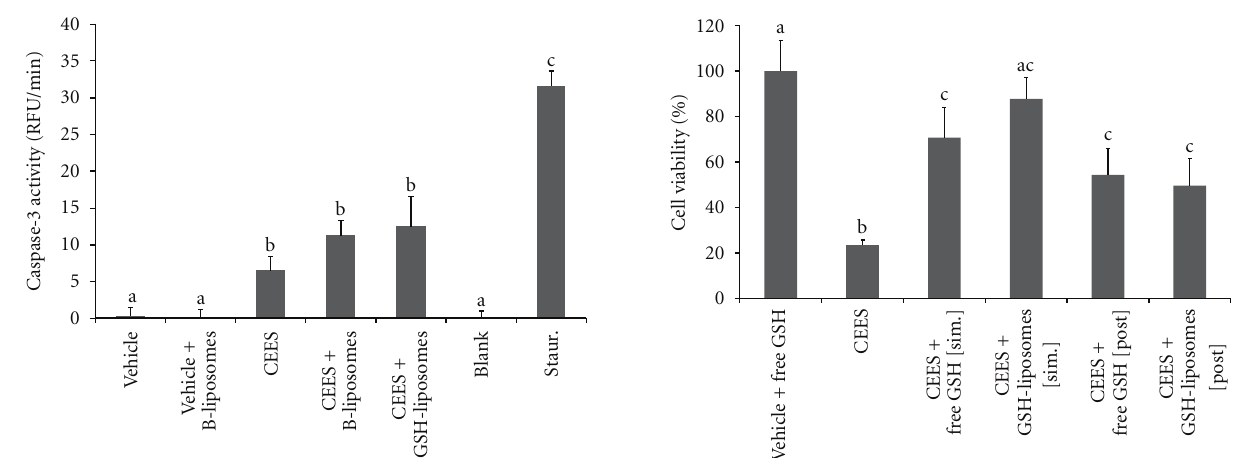
Figure 3: Protective e ff ects of antioxidant liposomes in the EpiDerm model . EpiDerm tissues were exposed topically to 2.5 mM CEES or vehicle (1% DMSO) in the absence or presence of Blank liposomes (B-liposomes), NAC-liposomes, and GSH-liposomes (as indicated) applied simultaneously with CEES or vehicle, but into the bottom media; the tissues were incubated at 37 ◦ C for 18 hours. Final “calculated” concentration of GSH or NAC was 10mM (see Section 2). Cell viability was monitored by the MTS assay (a). Cellular ATP was assayed in the tissue homogenates by the ATP assay (b). Means not sharing a common letter are significantly di ff erent ( P < . 05).